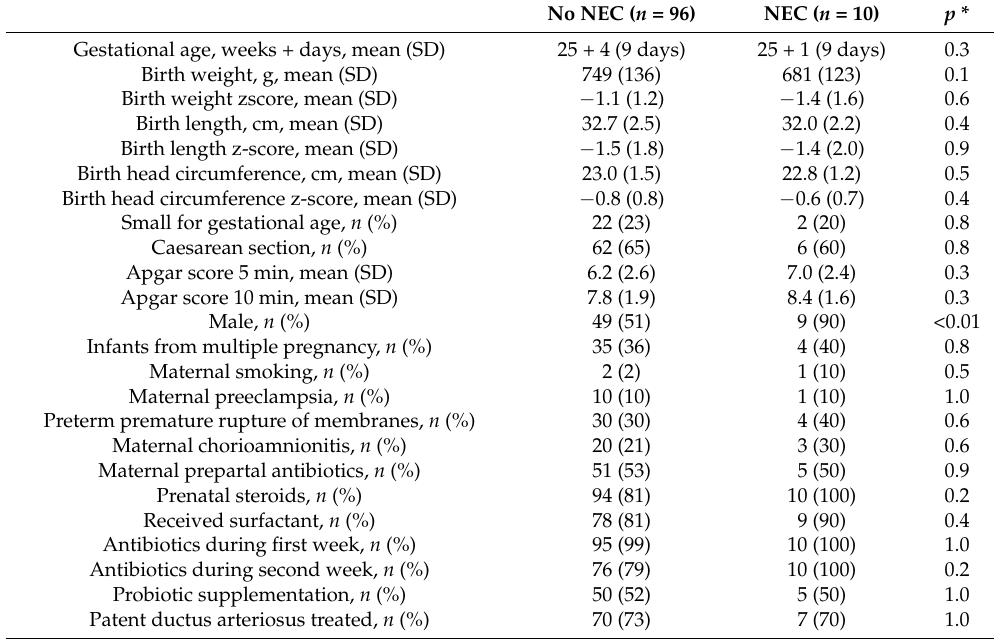
Table 2. Background characteristics in extremely low birth weight (ELBW) infants with and without necrotising enterocolitis (NEC) during the neonatal